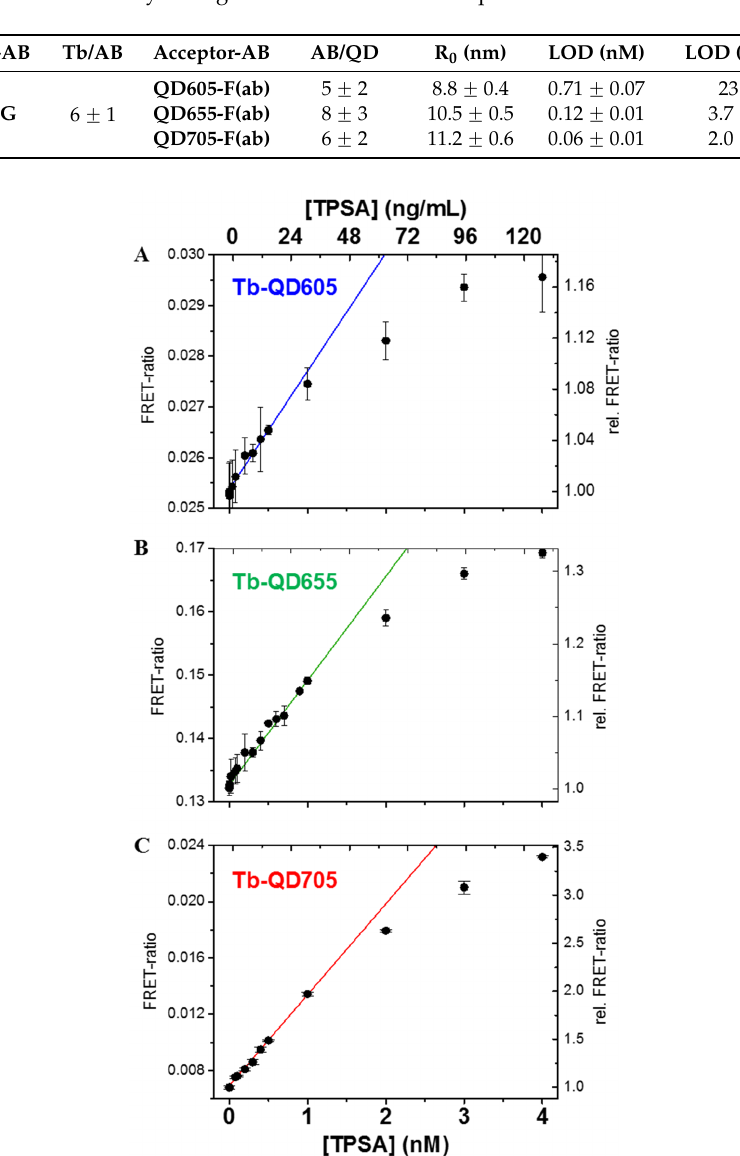
Figure 3. PSA immunoassay calibration curves of the different Tb-QD FRET systems using QD605 ( A ); QD655 ( B ); and QD705 ( C ). Bottom abscissae give total PSA (TPSA) concentrations in nM, top abscissae give TPSA concentration in ng/mL. LODs were determined using the linear parts of the calibration curves (solid lines) and the standard deviation of the FRET-ratio at zero TPSA concentration (Equation (4)).